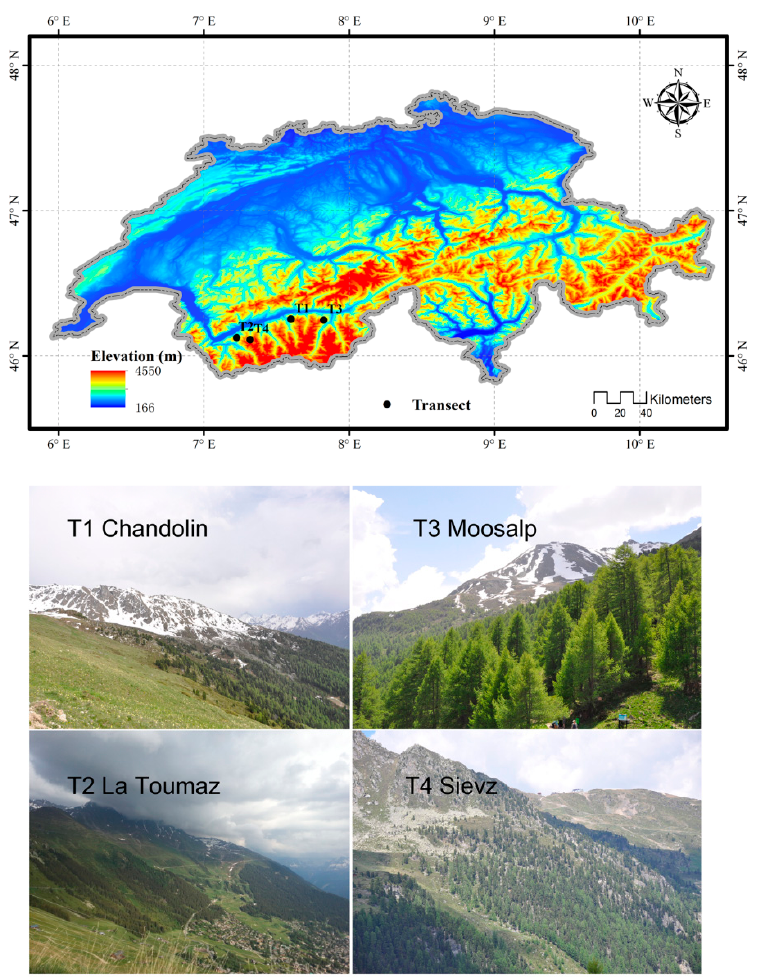
Figure 1. Locations of the sampled sites (T1: Chandolin, T2: La Toumaz, T3: Moosalp, and T4: Sievz) in the southern Swiss Alps.